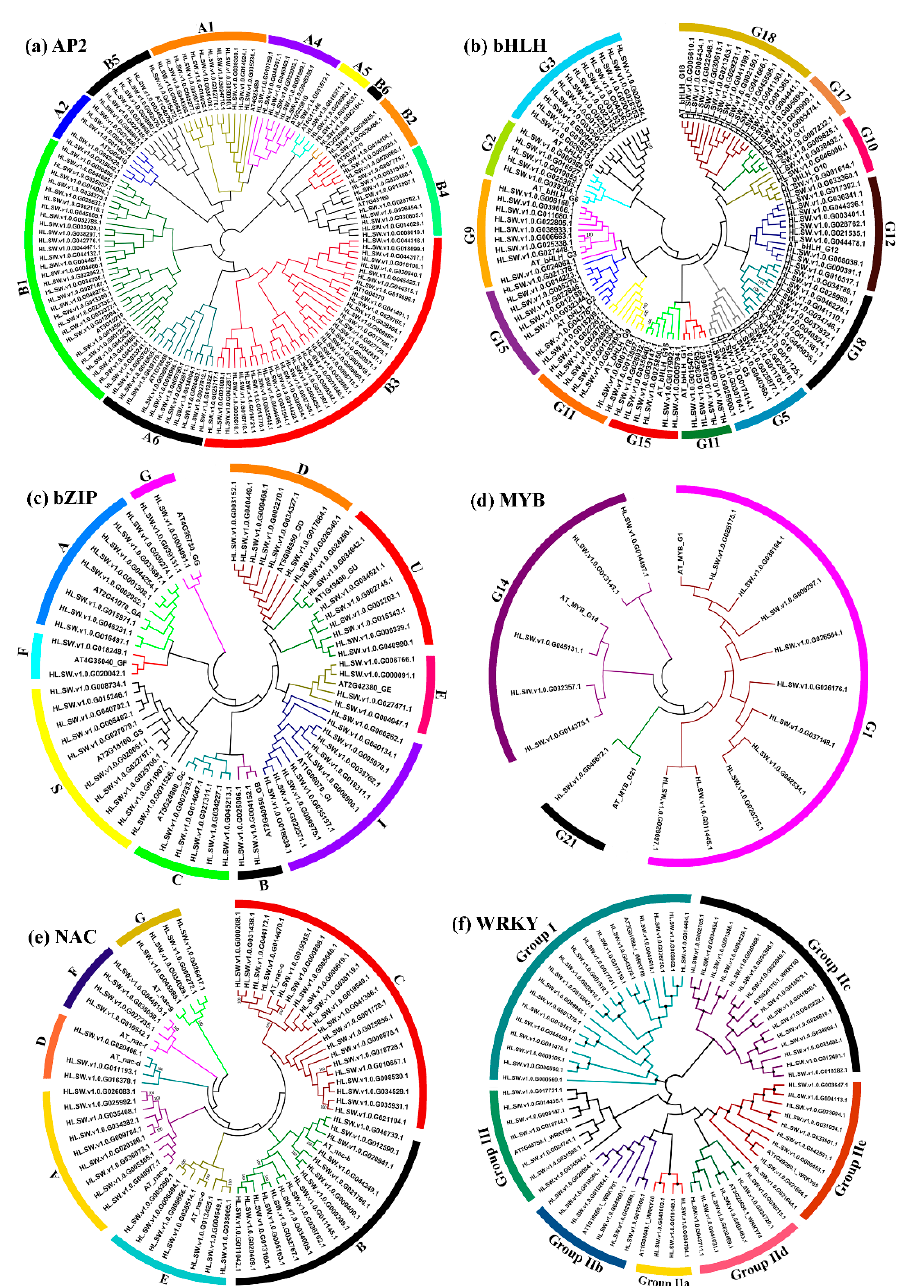
Figure 2. Unrooted phylogenetic tree representing the relationships and subfamily designations of the hop TF families along with the model species A. thaliana . The deduced amino acid sequences were aligned using the MUSCLE program, and the phylogenetic tree was constructed using the neighbor-joining method implemented in MEGA 7 software. The colored branch indicates the different subfamilies: ( a ) AP2, ( b ) bHLH, ( c ) bZIP, ( d ) MYB, ( e ) NAC and ( f ) WRKY.